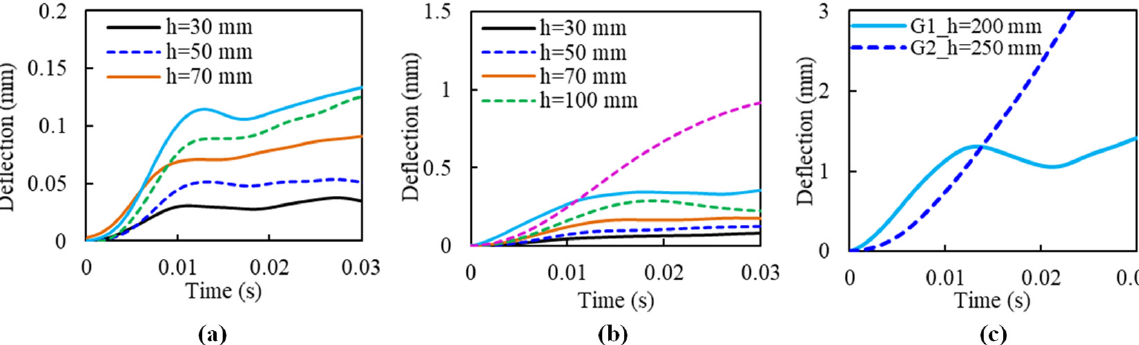
Figure 9. Deflection-time histories of G1 and G2 specimens under impact: ( a ) G1 with the impact height from 30 mm to 150 mm; ( b ) G2 with the impact height from 30 mm to 150 mm; ( c ) Deflection of G1 and G2 at failure.